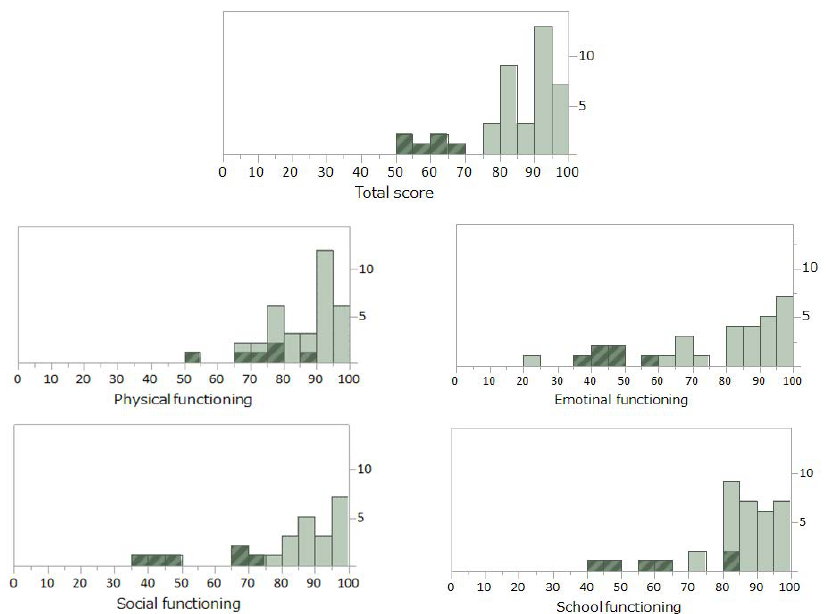
Figure 1. Histograms presenting the distribution of a measure for health-related quality of life (a total score and scores for subscales of PedsQL) in childhood cancer survivors ( n = 46). Six survivors defined as “low-PedsQL survivors” were shown by dark columns with diagonal lines.